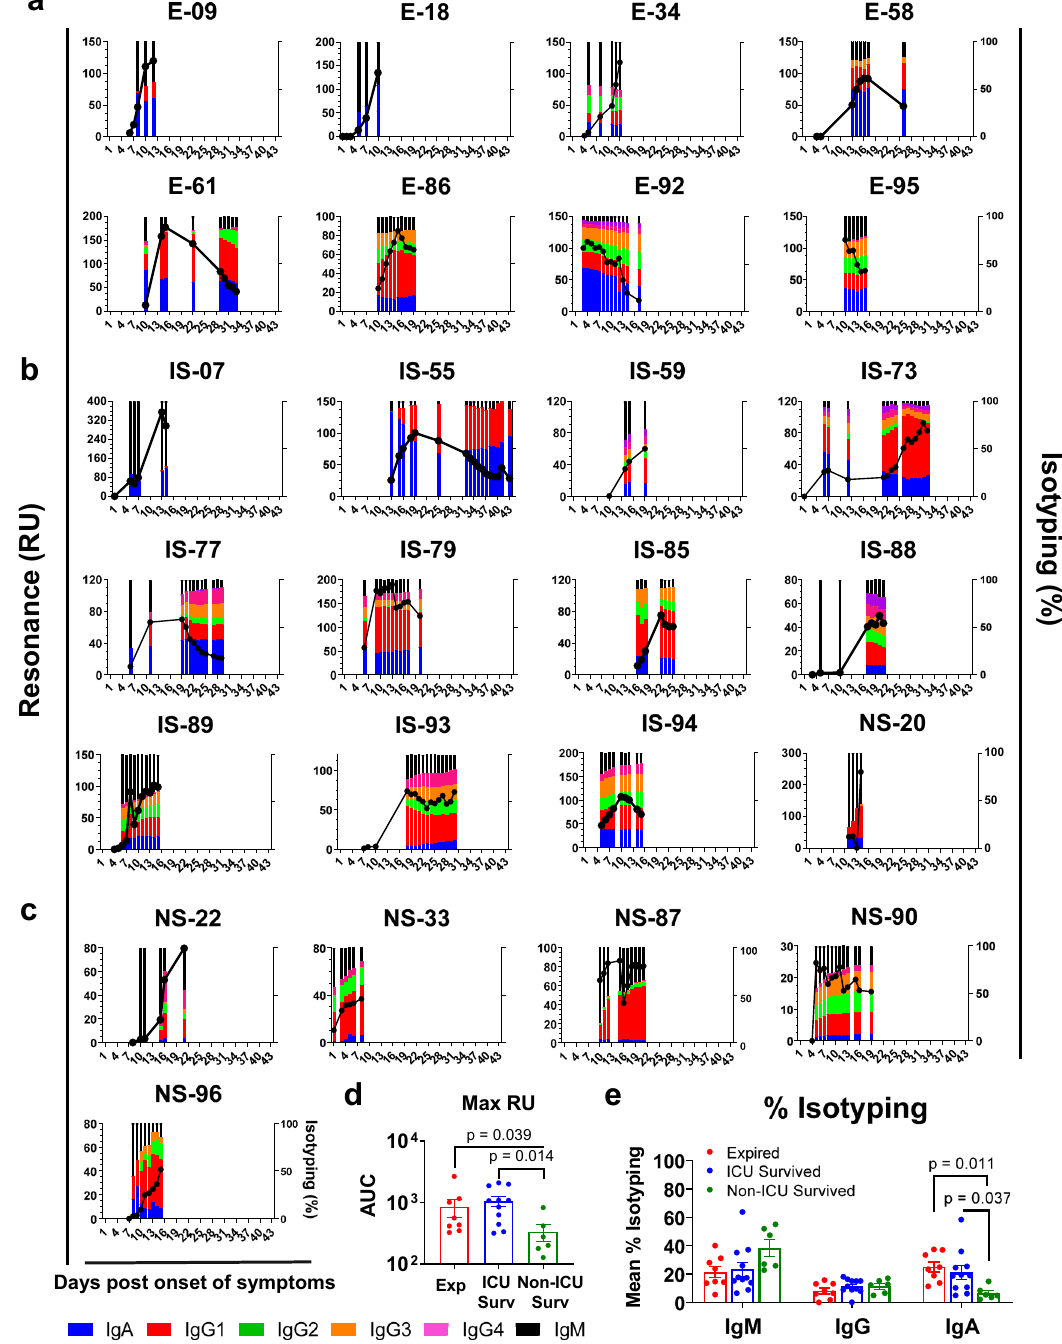
constants, which describe the stability of the antigen-antibody complex, i.e., the fraction of complexes that decays per second in the dissociation phase, were determined directly from the human polyclonal plasma sample interaction with recombinant puri fi ed SARS CoV-2 prefusion spike ectodomain using only sensorgrams with Max RU in the range of 10 – 100 RU. Off-rate constants were determined from two independent SPR runs. In the expired COVID-19 patients, low antibody af fi nity (faster antibody dissociation kinetics) was observed to the prefusion spike with mean fi nal day off-rate of 0.0173 per second (range of 0.045 to 0.0056 per second) during hospitalization (Fig. 6a and Suppl. Fig. 8b, red curve). In these fatal cases, minimal or no anti-